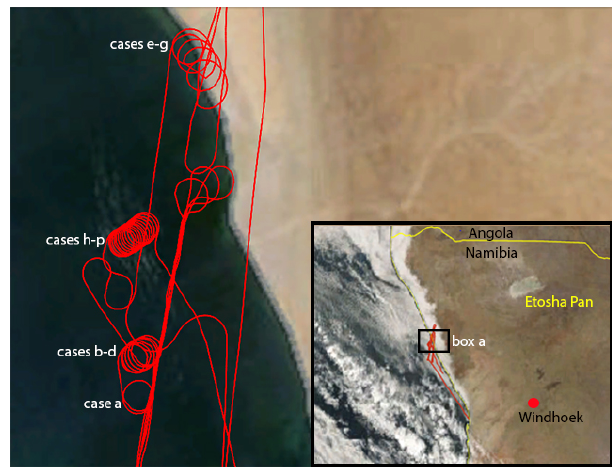
Figure 1. Location of the measurements. On 13 September 2000, NASA’s Cloud Absorption Radiometer (CAR) on board the Uni- versity of Washington Convair-580 research aircraft obtained mea- surements over marine stratocumulus offshore of Namibia at sev- eral locations marked by the aircraft ground track on the inset map. The aircraft completed multiple circular flight tracks ( > 16) at dif- ferent locations, shown on the enlarged map of the rectangular box area and labeled alphabetically as a–p based on the time of obser- vations (see Table 1). The circular flight tracks were performed pri- marily for the airborne measurements of bidirectional reflectance distribution function (BRDF) (cases a–d and h–p) and in a few instances (cases e–g) represent vertical profiles for physical and chemical measurements. The marine stratus clouds were extensive, as seen by the MODIS Terra instrument on the same day at around 09:25UTC (see the map inset). The CV-580 flight began just prior to 10:00UTC and ended at 13:00UTC. The enlarged map is derived from a GWELD-generated browse image (Roy and Zhang